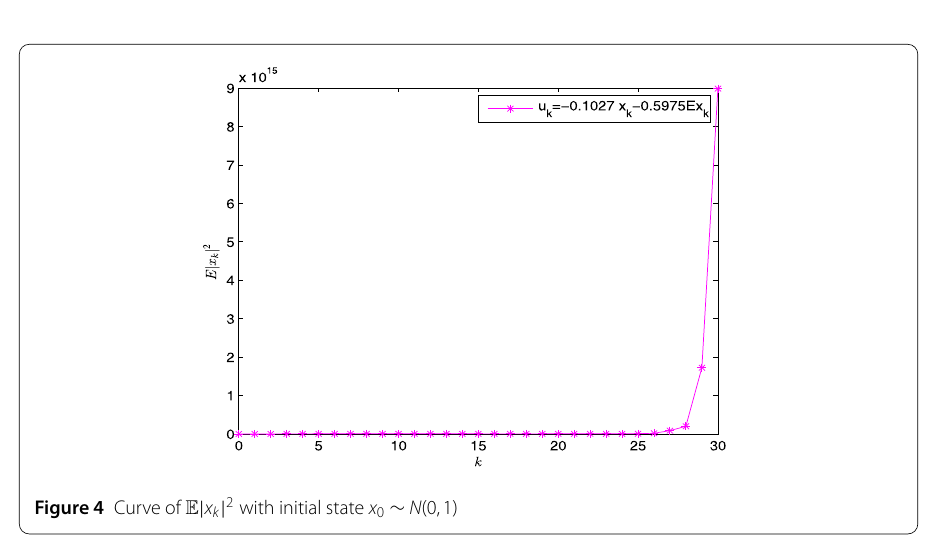
Figure 4 Curve of E | x k | 2 with initial state x 0 ∼ N